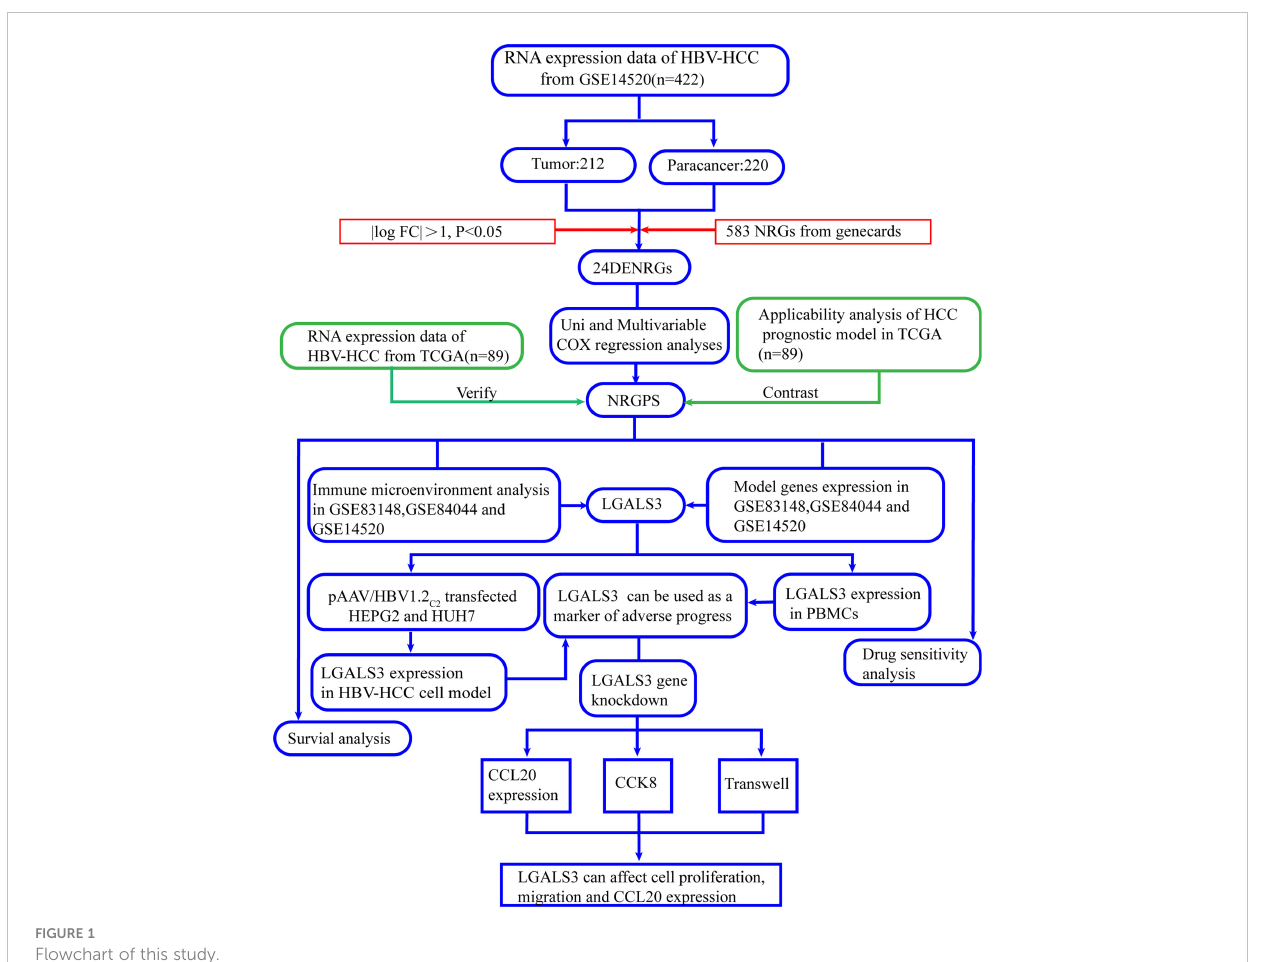
FIGURE 1 Flowchart of this